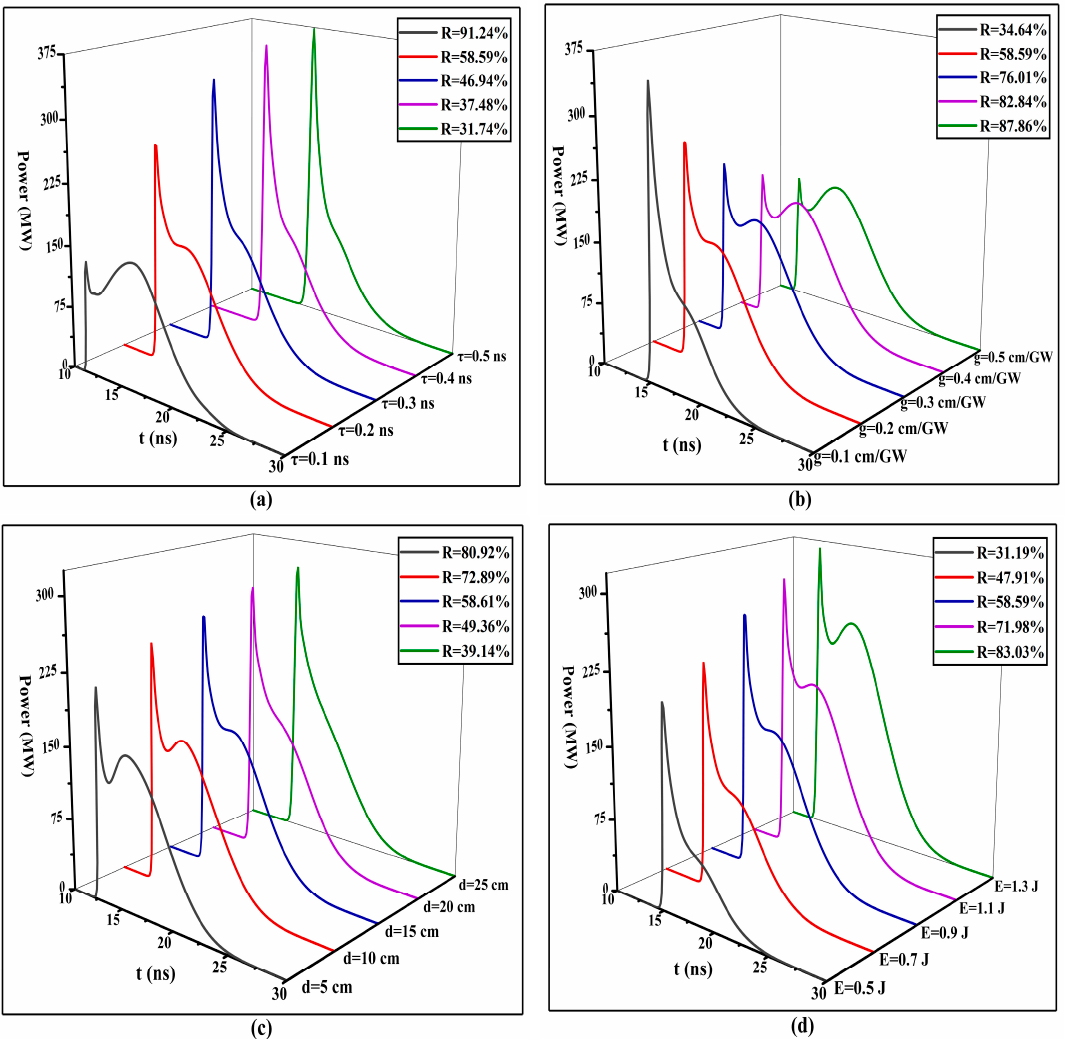
Figure 2. Evolution of Stokes temporal waveform and change in the ratio of trailing-edge energy to the entire waveform energy (R) with different phonon lifetimes ( τ ), Brillouin gain coefficients (g), interaction lengths between the Stokes and the pump (d), and pump energies (E): ( a ) phonon lifetime varying from 0.1 ns to 0.5 ns; ( b ) Brillouin gain coefficient varying from 0.1 cm/GW to 0.5 cm/GW, with a phonon lifetime of 0.2 ns; ( c ) the interaction length between Stokes and the pump varying from 5 cm to 25 cm, with a phonon lifetime of 0.2 ns and Brillouin gain coefficient of 0.2 cm/GW; ( d ) pump energy varying from 0.5 J to 1.3 J, with a phonon lifetime of 0.2 ns, Brillouin gain coefficient of 0.2 cm/GW, and an interaction length between Stokes and the pump of 15 cm.